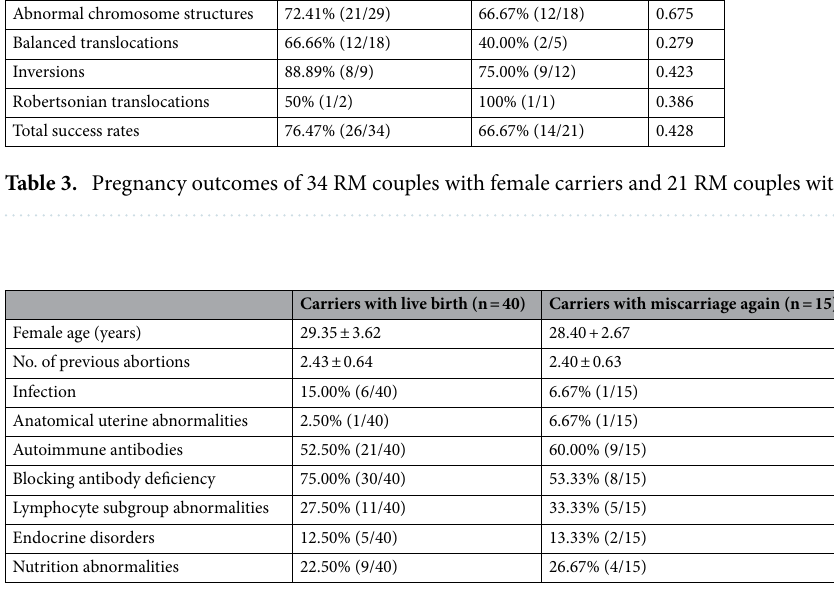
Table 4. Other relevant causes of 40 RM couples with live birth and 15 RM couples with miscarriage